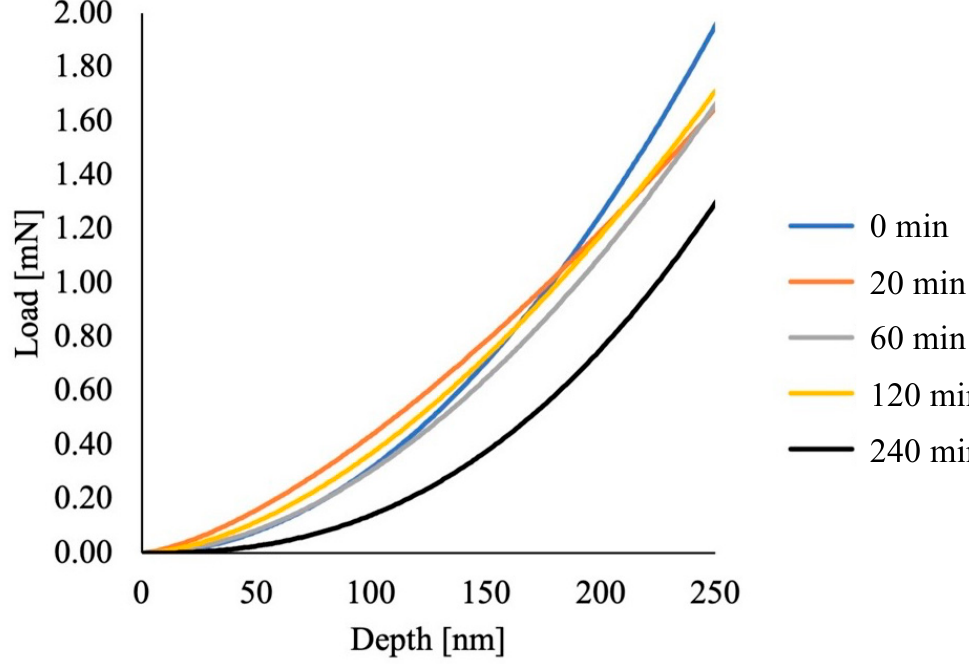
Figure 15. Average power-law fit load–depth curves for the studied and thermally pre-processed (and as-atomized) conditions.